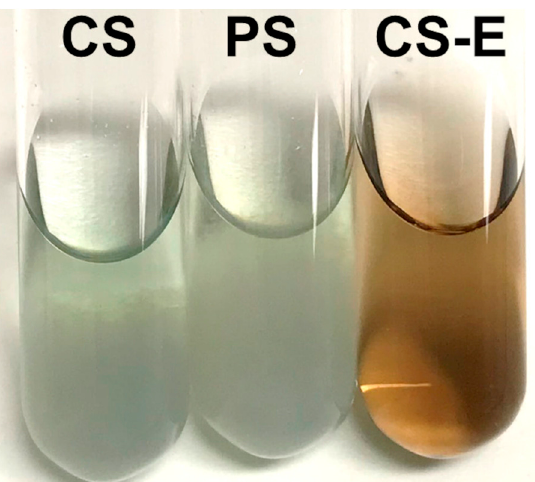
Figure 2. Staining of aqueous solutions of crude sericin (CS), purified sericin (PS), and extract of crude sericin (CS-E) following treatment with the DAC reagent in methanolic acidic medium. Photographs were taken after 1 h at room temperature. The red-brown coloration denotes the presence of flavonoids in the sample.